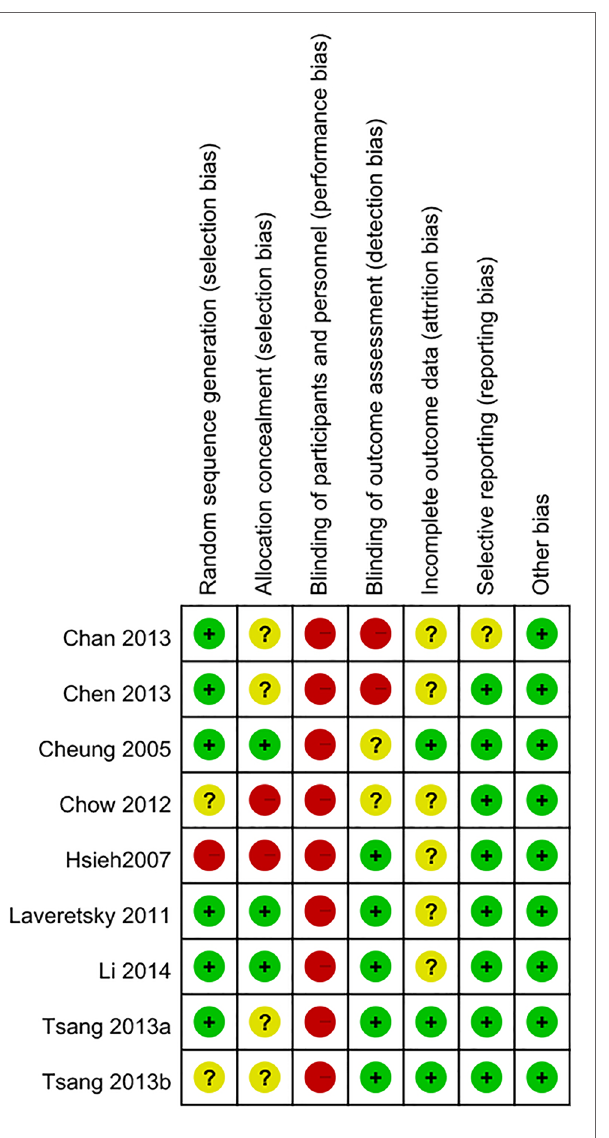
FiGURe 5 | Summary or risk